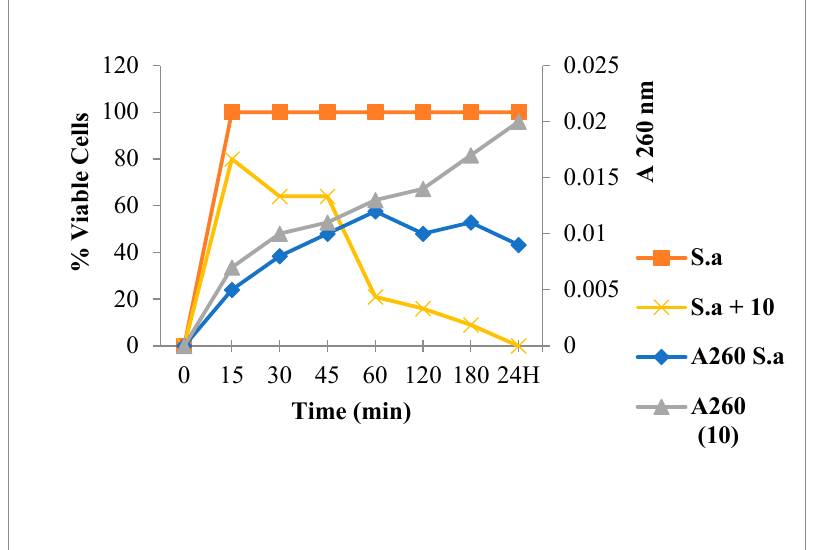
Figure 4. 260 nm absorbent material release and viability of S. aureus following Chalcone 3 treatment.